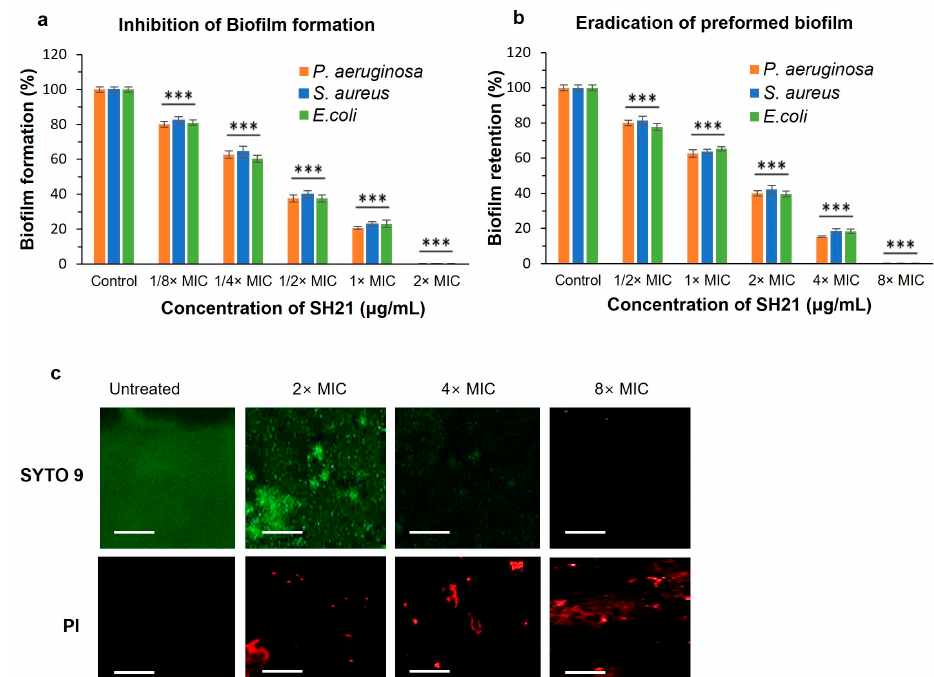
Figure 6. Antibiofilm effect of protease SH21. ( a ) Inhibition of biofilm formation and ( b ) eradication of preformed biofilms against P. aeruginosa , S. aureus , and E. coli . ( c ) Effects of protease SH21 on P. aeruginosa 48 h-old biofilms evaluated by applying confocal laser scanning microscopy (CLSM). P. aeruginosa was incubated alone or with three different concentrations (2× MIC, 4× MIC, and 8× MIC) of SH21. Live–dead viability staining (SYTO 9/PI) was used to visualize biofilms. Green fluorescence (SYTO 9) and red fluorescence (PI) indicated live and dead cells, respectively. Scale Bars = 50 μ m. “***” indicate statistically significant differences at p < 0.001.